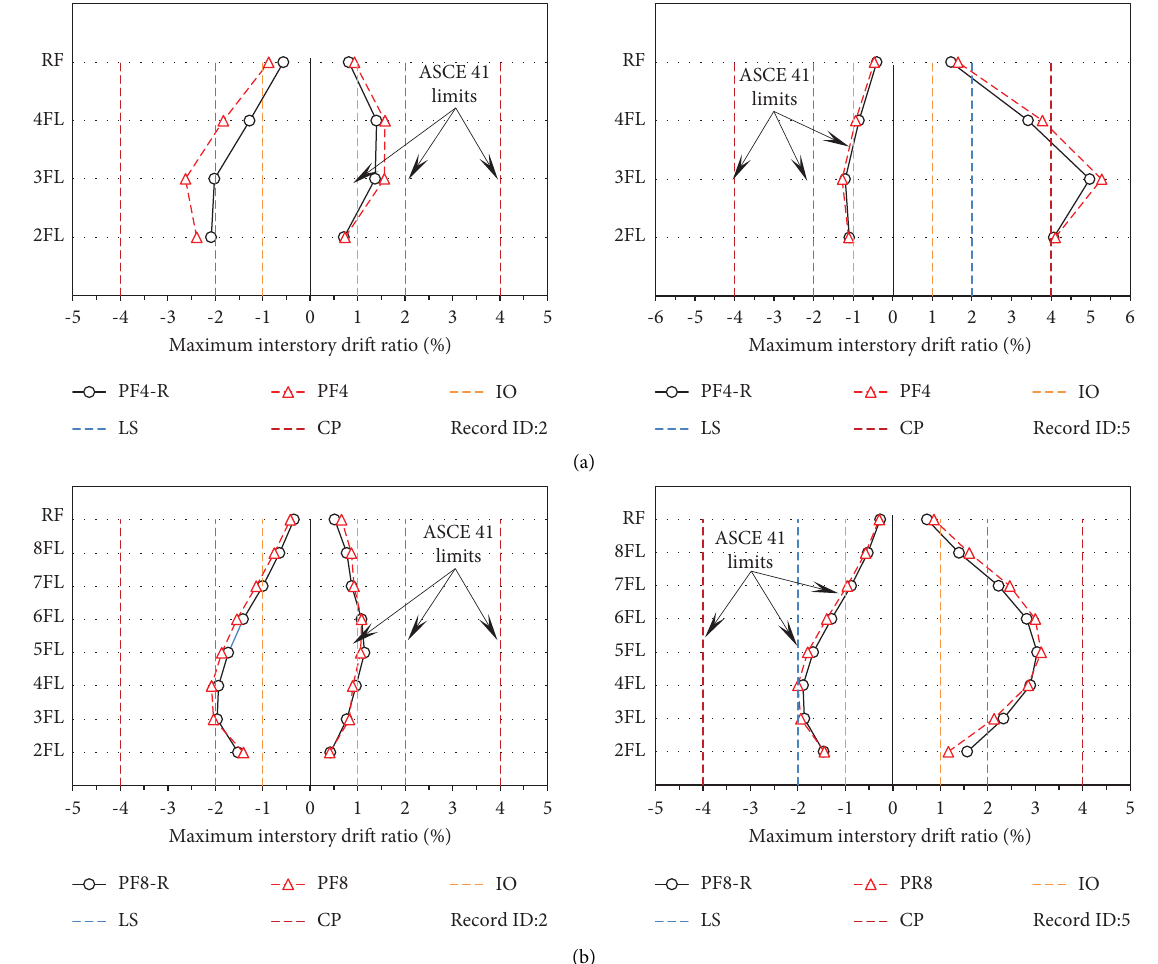
Figure 12: Maximum transient interstory drift ratio of each story. (a) A four-story frame. (b) An eight-story